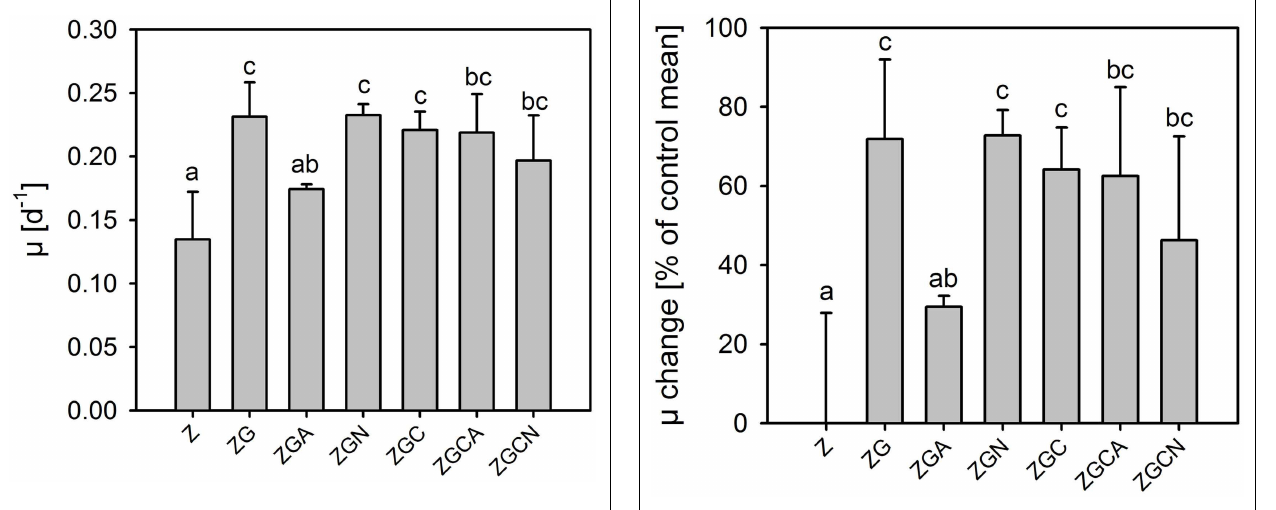
FIGURE 2 | Relative growth rates (mean ± SD, n = 6) of Chlorella mirabilis under different nutrient treatments in the in-door micro-scale mass cultivation experiment . See Table 1 for treatment abbreviations.The same letter indicates homologous groups as recognized by theTukey HSD test at p = 0.05; the Z medium (control) is included in the group labeled “a.”